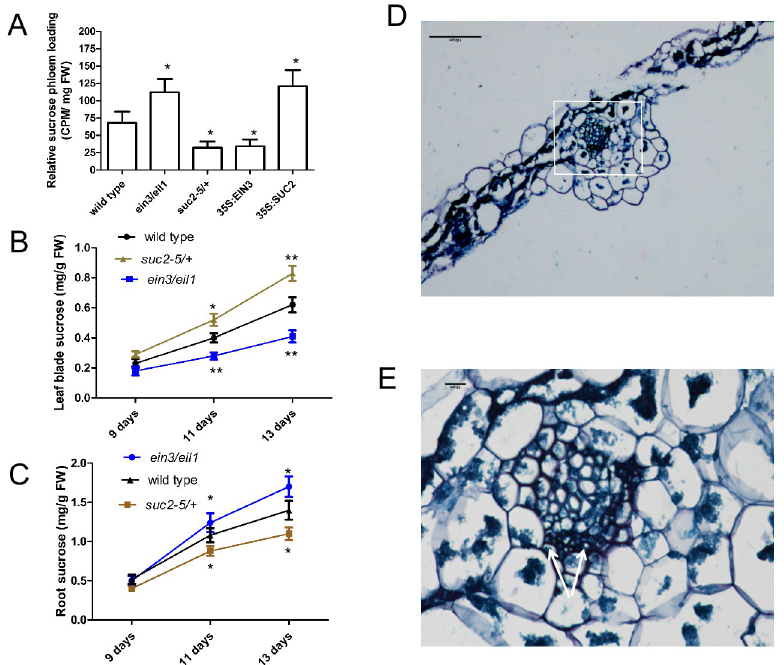
Fig 6. Sucrose phloem loading of mature leaves or shoot apex and sucrose levels from a few lines. A , Phloem loading of sucrose in wild-type, ein3/eil1 , suc2-5/+ , 35S : EIN3 and 35S : SUC2 vegetative leaves. These seedlings were grown in soil for 15 days under short days and normal light conditions, and vegetative leaves were immersed in the sucrose phloem loading buffer with [ 14 C] sucrose and incubated for 3 hours. The amount of [ 14 C] sucrose phloem loading was assayed via a scintillation counter. FW, Fresh weight. B , Levels of vegetative leaf sucrose (source tissue) in 9-, 11- and 13-day-old ein3/eil1 , suc2-5/+ and wild-type plants grown in soil at exposure to light for 4 hours. Sucrose per gram fresh weight. C , Levels of root sucrose (sink tissue) in 9-, 11- and 13-day-old ein3/eil1 , suc2-5/+ and wild-type plants grown in soil at exposure to light for 8 hours. Sucrose per gram fresh weight. Error bars represent SD (n =